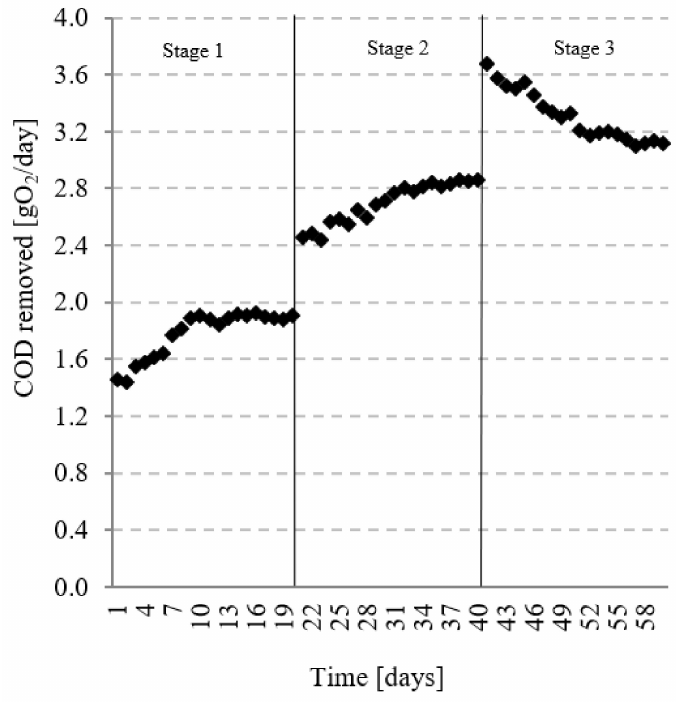
Figure 4. COD load removed during